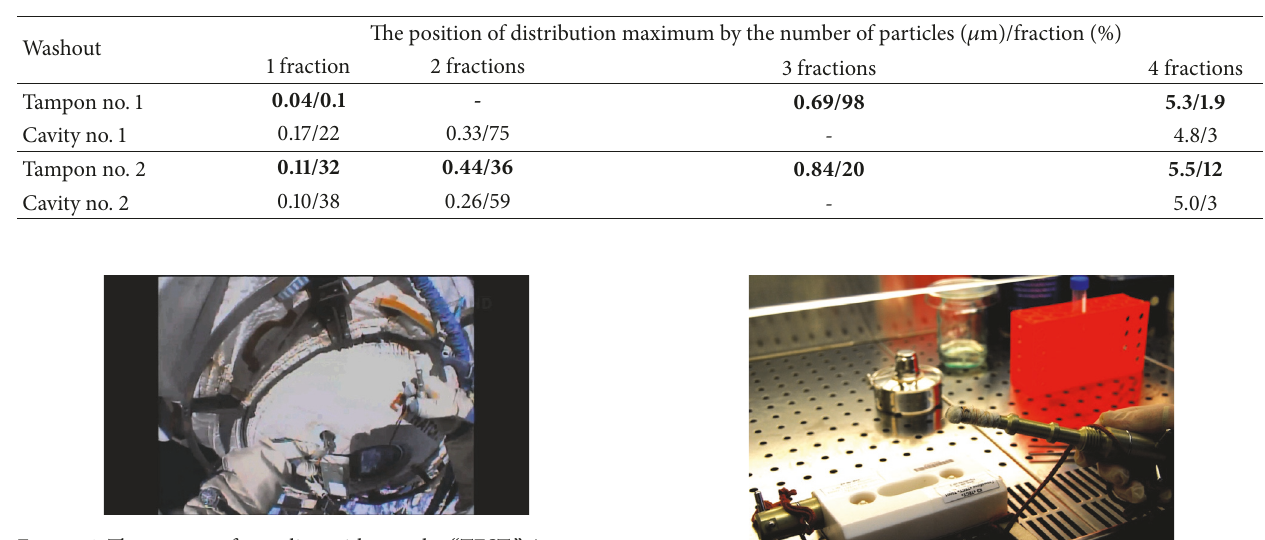
Table 1: Disperse composition of the washouts from the tampon and “TEST” sampler cavity.